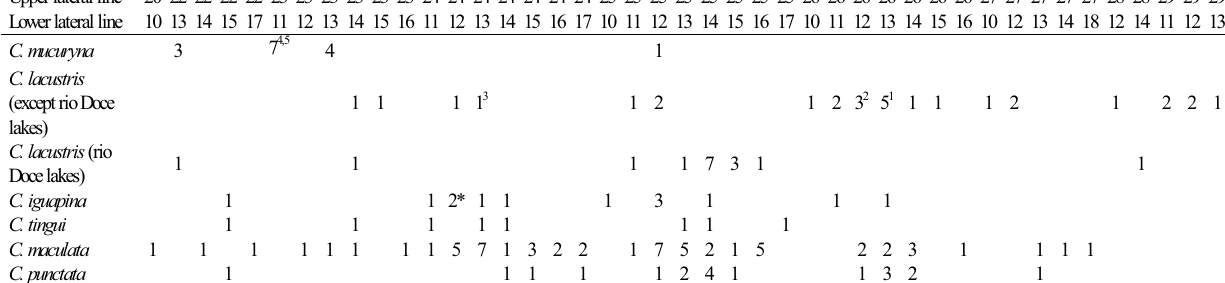
opercle; specimens over 60 mm with well evident spots on head.